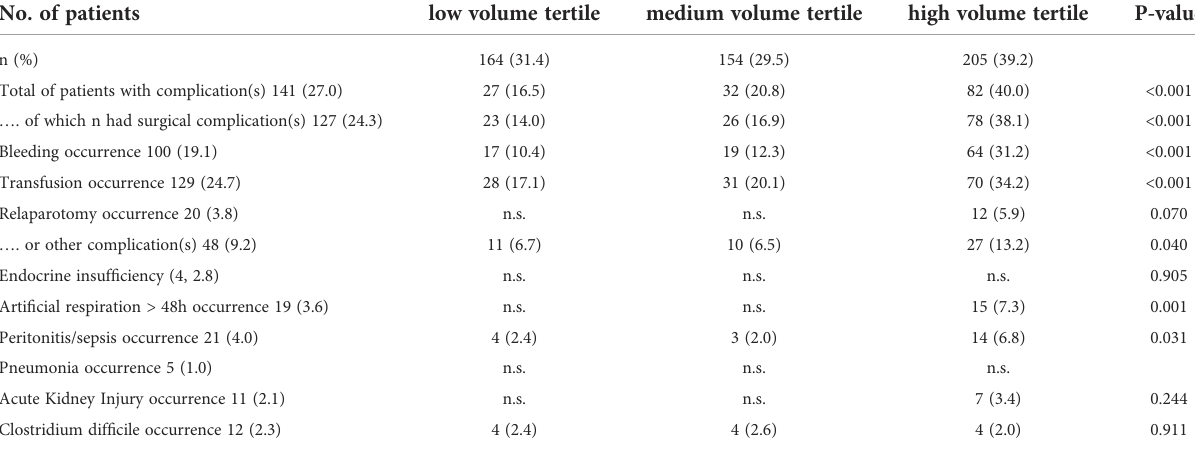
TABLE 5 Patients ≤ 21 years of age: complications by patient